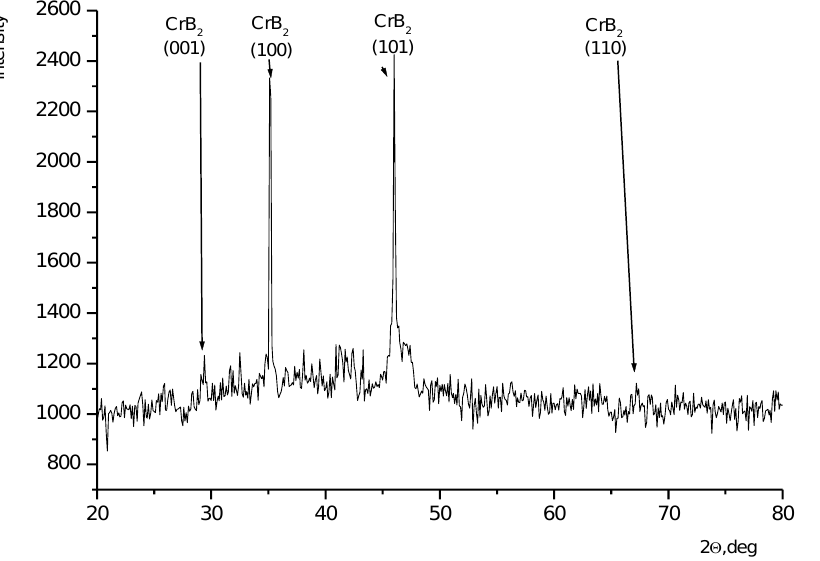
Figure 6. XRD diagram of the initial powder of CrB 2 .